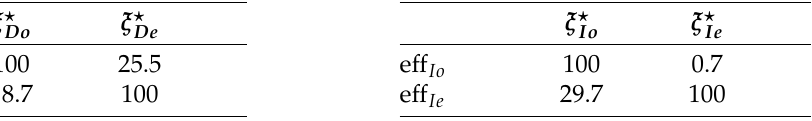
Table 2. Cross efficiencies, expressed as percentages of the optimal designs for the homoscedastic and heteroscedastic models when the true variance structure changes. The first table presents efficiencies for φ D while the second does for φ I